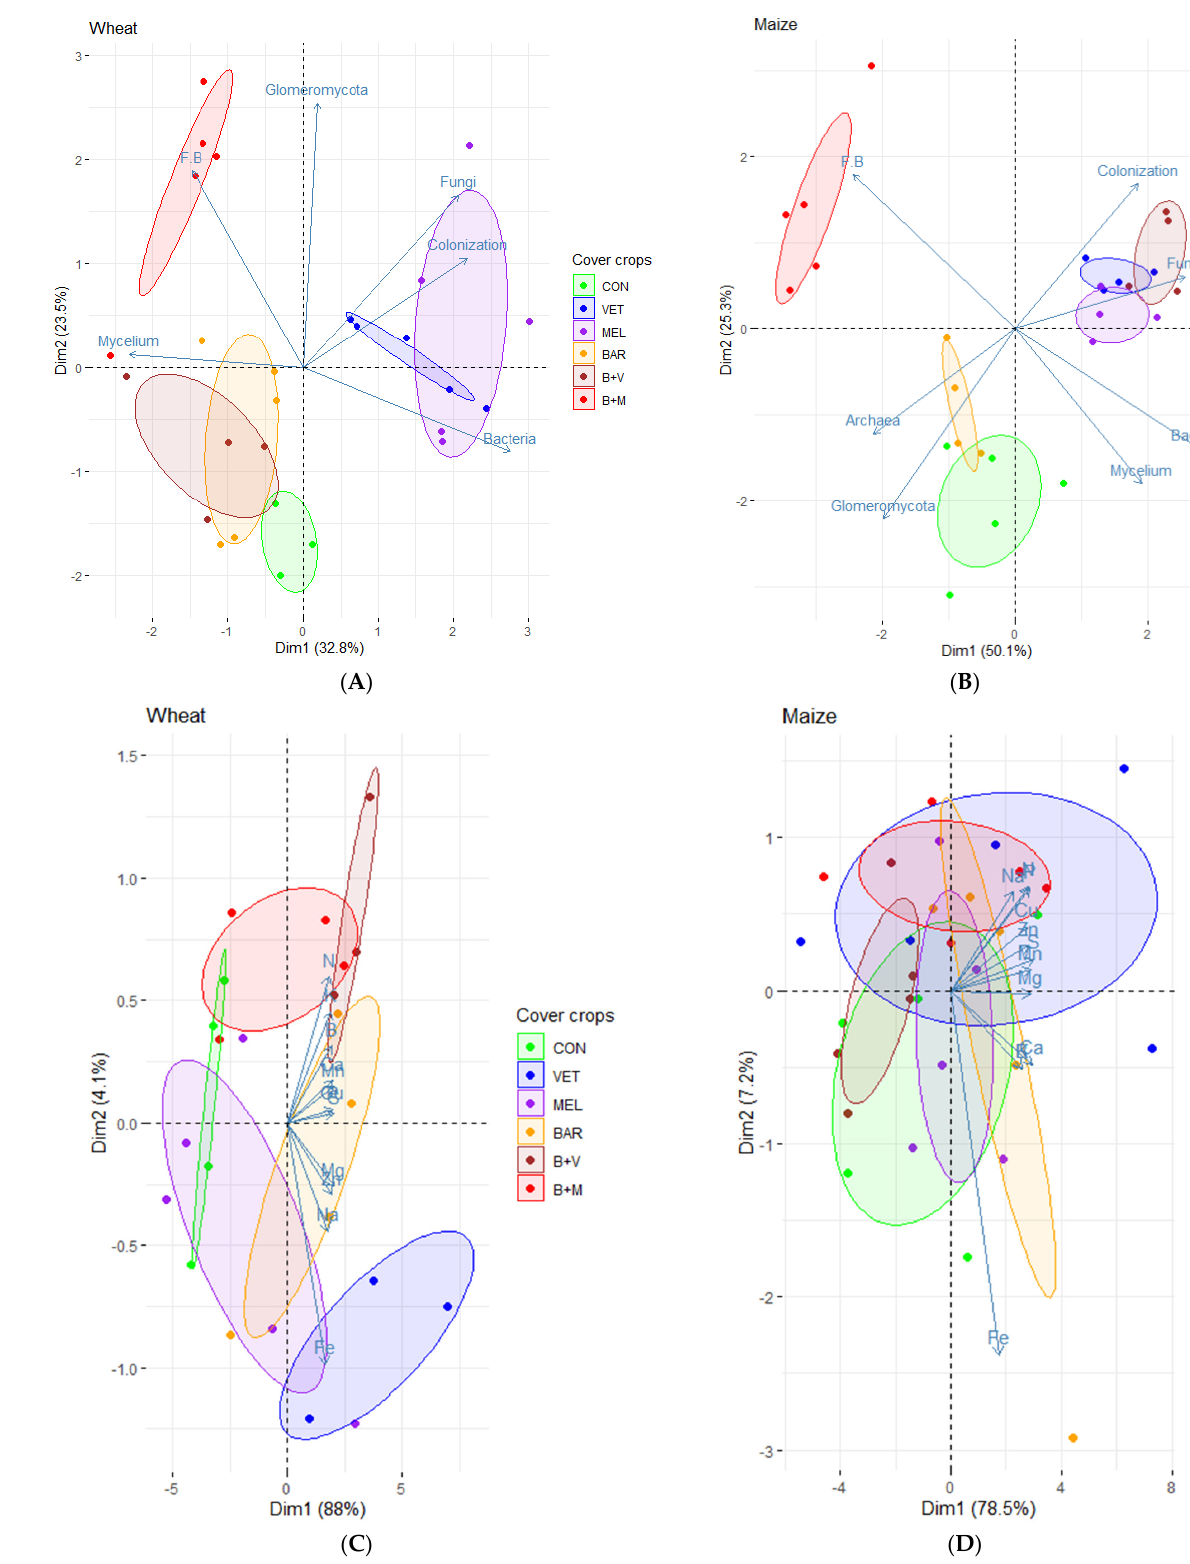
Figure 1. Analysis of principal components of the microbial variables of the soil in wheat ( A ) and in maize ( B ); and, crop variables in wheat ( C ) and in maize ( D ).